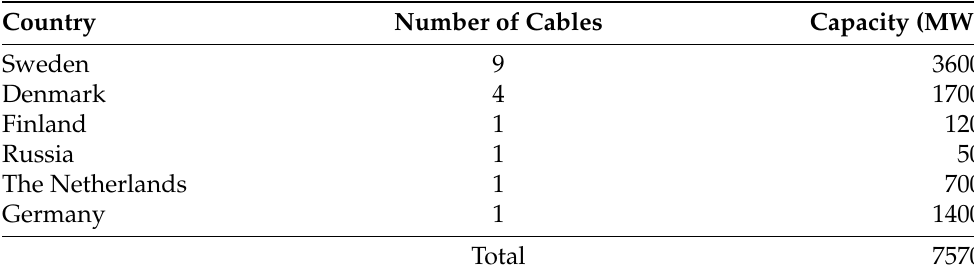
Table 10. Cables from Norway to nearby countries. Capacity in